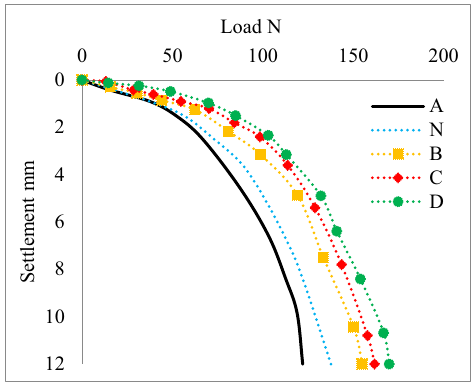
Figure 12: Load – settlement relations for footings resting on soil grouted at the perimeter of the footing area.